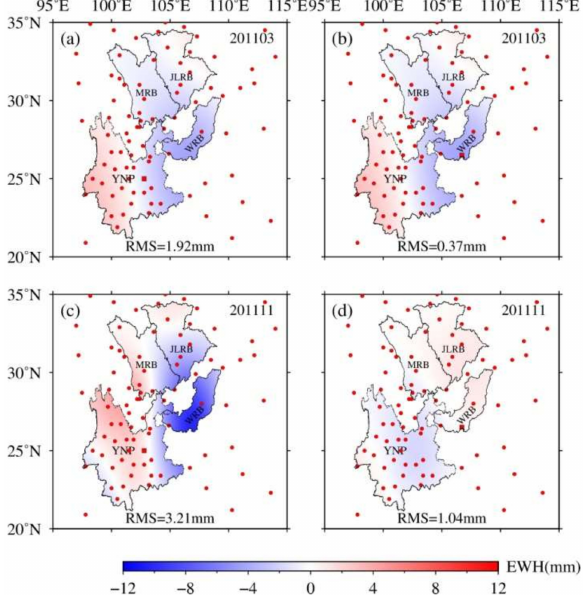
Figure 5. Di ff erences of surface mass variations derived from simulated GPS vertical displacements in March (top) and November (bottom) 2011, respectively. ( a ) and ( c ) show the di ff erences between the inversion results of 85 GPS stations and those of stations without GZGY; ( b ) and ( d ) show the di ff erences between the inversion results of 85 GPS stations and those of stations without KMIN. The red dots represent the location of GPS stations, but the locations of GZGY and KMIN are indicated as red